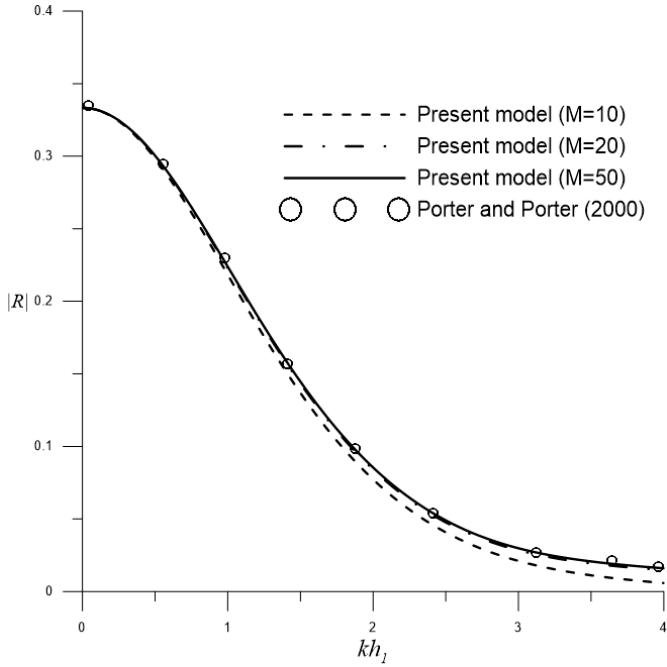
Figure 6. Reflection coefficient | R | varying against kh 1 for water waves be scattered by undulated slope bottom.